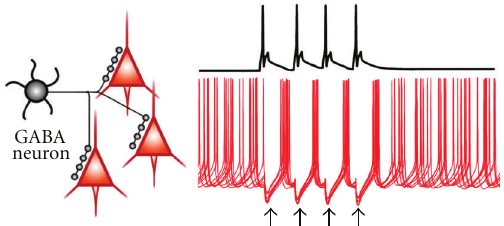
Figure 2: A model for GABA A R-mediated synchronization mech- anisms. The left panel shows a group of pyramidal cells that are common postsynaptic targets of an inhibitory GABA neuron. Perisomatic-targeting GABA neurons such as that in the scheme produce stronger inhibition than GABA neuron subtypes that target the dendrites. The right panel shows, above (black trace), the mem- brane potential of the GABA neuron which remains at rest before and after firing a sequence of four action potentials. The red traces below show the membrane potential simultaneously recorded from the postsynaptic pyramidal neurons, which are firing in response to a continuous excitatory input. Note that, before the GABA neuron starts firing, the pyramidal cells fire in an asynchronous manner. Shortly after the first GABA neuron spike, an inhibitory postsynap- tic potential (IPSP) is produced (first black arrow) which simulta- neously inhibits the firing of all pyramidal neurons. After the IPSP- mediated inhibition decays, the pyramidal neurons fire in nearly synchrony. Note that a similar postinhibition synchronization is observed with each of the IPSPs evoked by the interneuron spikes (each IPSP is denoted by a black arrow). Once the GABA neuron stops firing, pyramidal cell activity rapidly becomes asynchronous. Also note that a single action potential in a GABA neuron would synchronize the pyramidal cells only once, whereas production of a synchronized oscillation requires rhythmic GABA neuron firing. An oscillation episode composed of four cycles is shown in the figure. The production of synchronized oscillations via this mechanism may be impaired by various alterations of GABA A R-mediated synaptic inhibition in schizophrenia (see Figure 1 and main